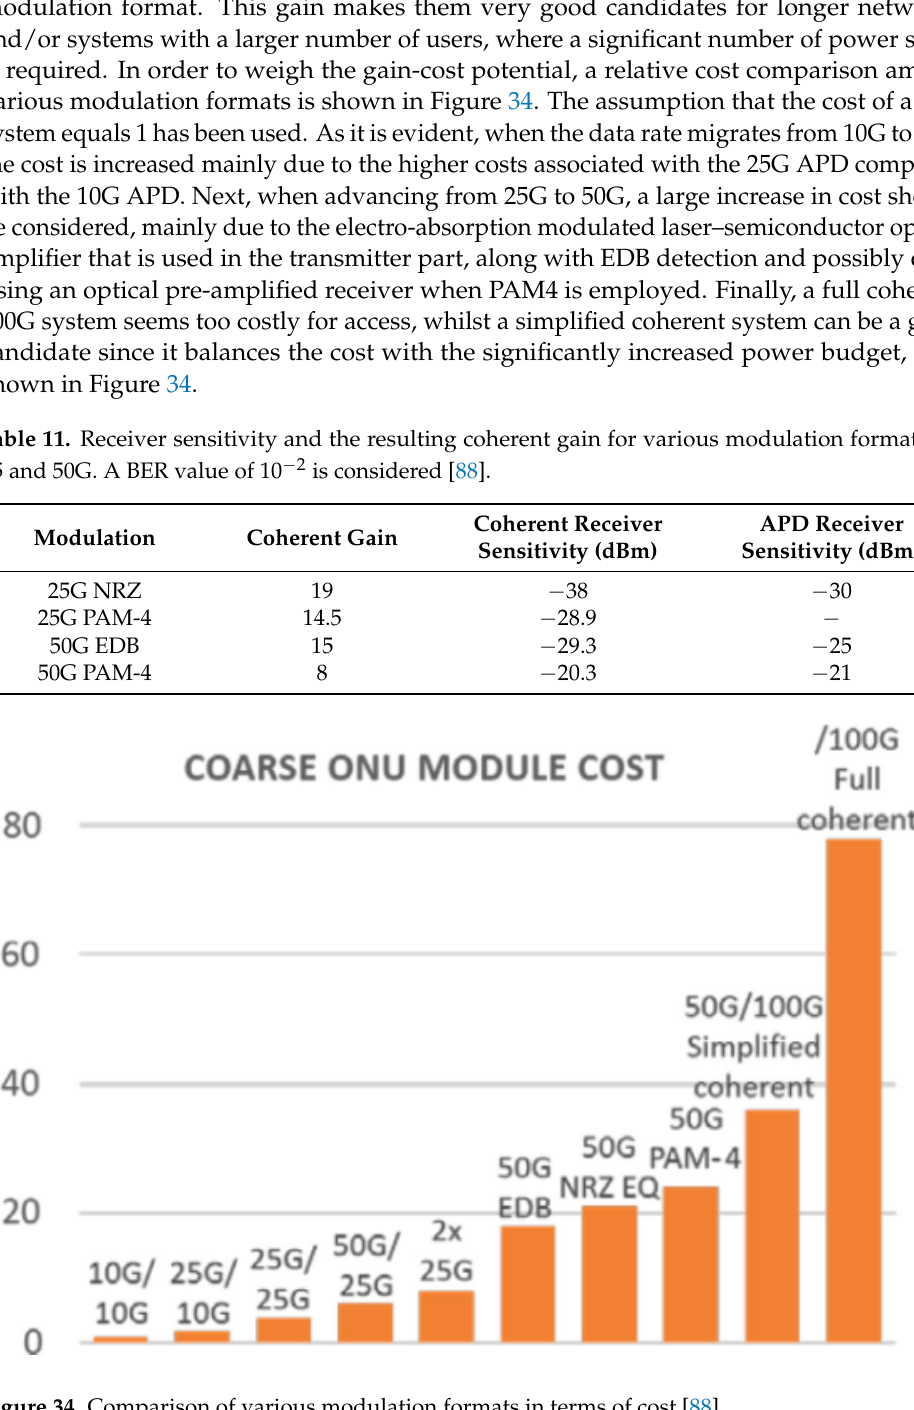
Table 11. Receiver sensitivity and the resulting coherent gain for various modulation formats for 25 and 50G. A BER value of 10 −2 is considered [88].